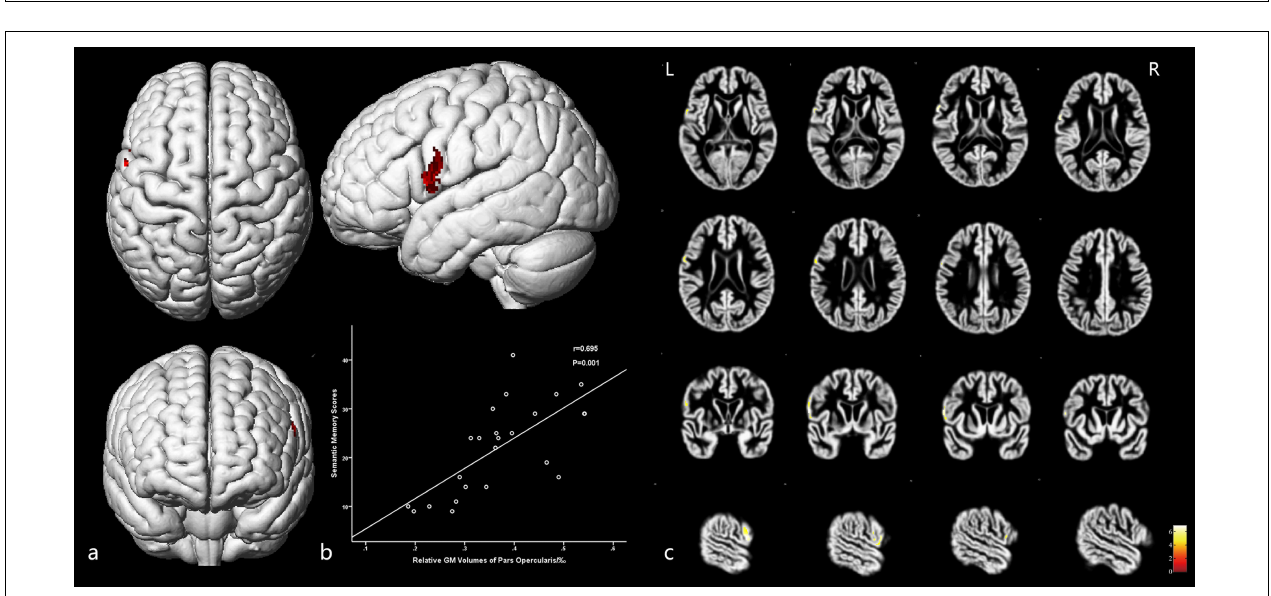
FIGURE 5 | The cortex related to associative memory and their Pearson correlation coefficients. (a) Three-dimensional image. (b) Correlation between associative scores and regional relative GM volumes. (c) Slice view. GM volumes of the anterior medial frontal gyrus cortex were positively related with the associative memory scores. L: left, R: right.